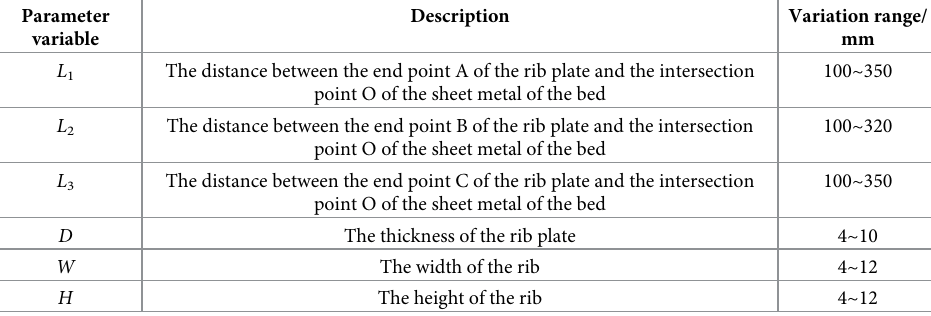
Table 4. Optimized parameters and their value ranges.